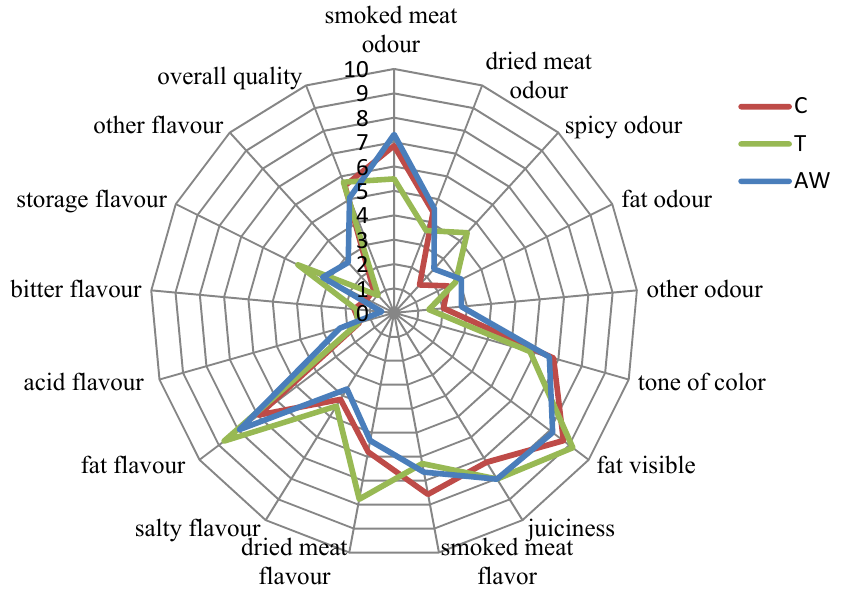
Figure 1. Sensory profile of the fermented pork